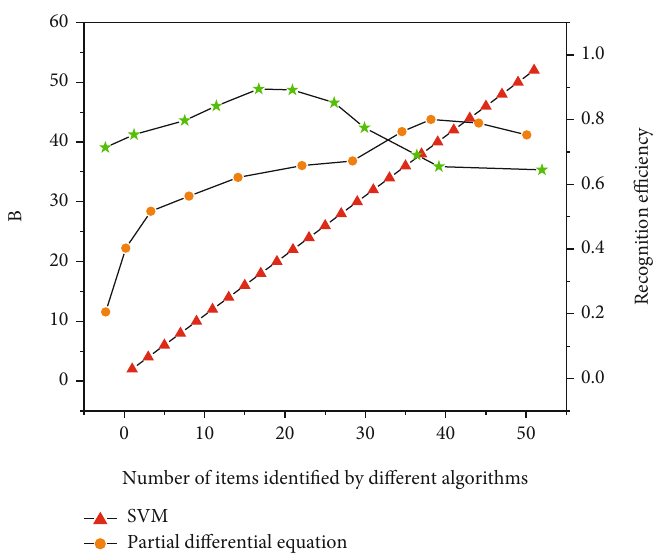
Figure 3: Average distance method based on PCA features and the result of corrected image recognition.